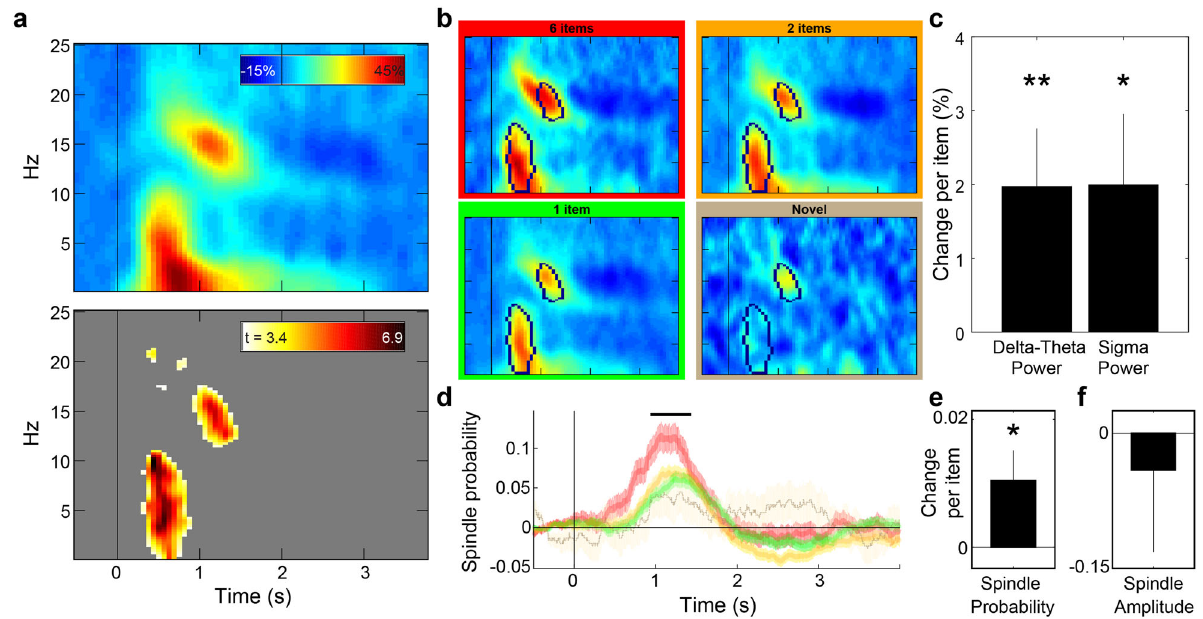
Fig. 4 Sleep spindles and delta-theta power following cue presentation were in fl uenced by set size. a Top - spectrograms displaying the baseline- corrected time-frequency responses to cue presentations (regardless of set size) during sleep averaged over participants. Time zero represents cue onset during sleep. Bottom - t -value map re fl ecting threshold-crossing ( p < 0.001, corrected) points in the time-frequency space. Two major clusters re fl ect delta-theta (0 – 11 Hz) and sigma (11.5 – 17.5 Hz) evoked activity following cue onset. b Spectrograms averaged across trials for the different set sizes. Black outlines mark the identi fi ed clusters. c Modulation coef fi cient of the number of items associated with a sound on delta-theta (left) and sigma (right) power (i.e., the change in power with each additional item). d Time-locked modulation of spindle probability following cue onset for different set sizes. Black line marks the timeframe detected for the sigma cluster, which was used for the analyses shown in the next panels. e Modulation coef fi cient of the number of items associated with a sound on spindle probability. f Modulation coef fi cient of the number of items associated with a sound on the amplitude of spindles occurring after sound onset. Error bars and shaded areas signify standard error of the mean. Data from electrode location Cz. ** p < 0.01; * p <